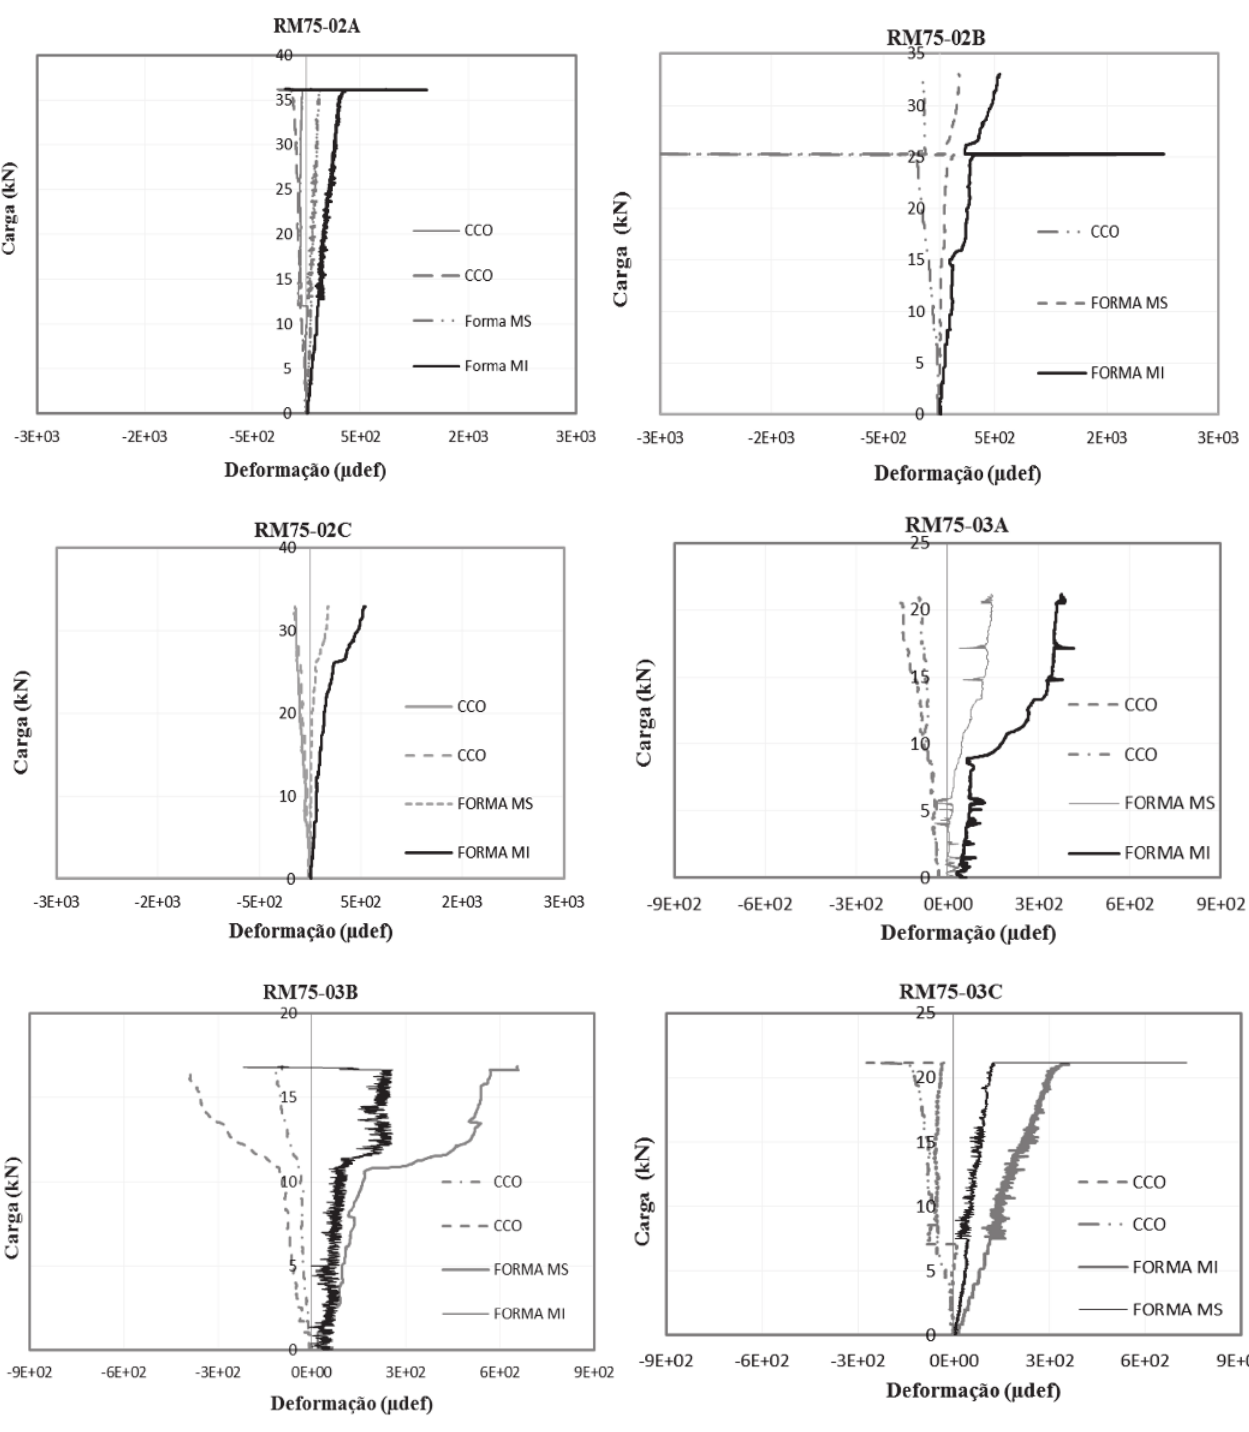
Carga x Deformação da amostra RM75 modelo